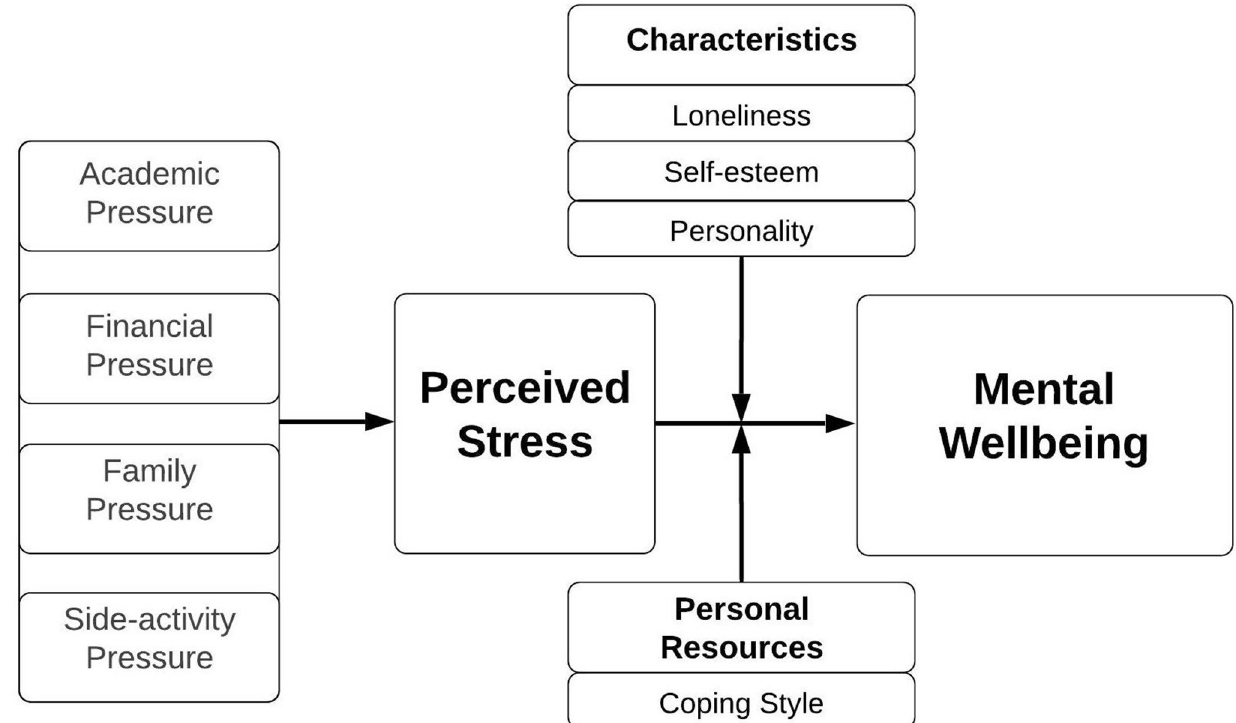
Fig 1. Conceptual model of the relationship between underlying stressors, perceived stress, characteristics, personal resources, and mental wellbeing.